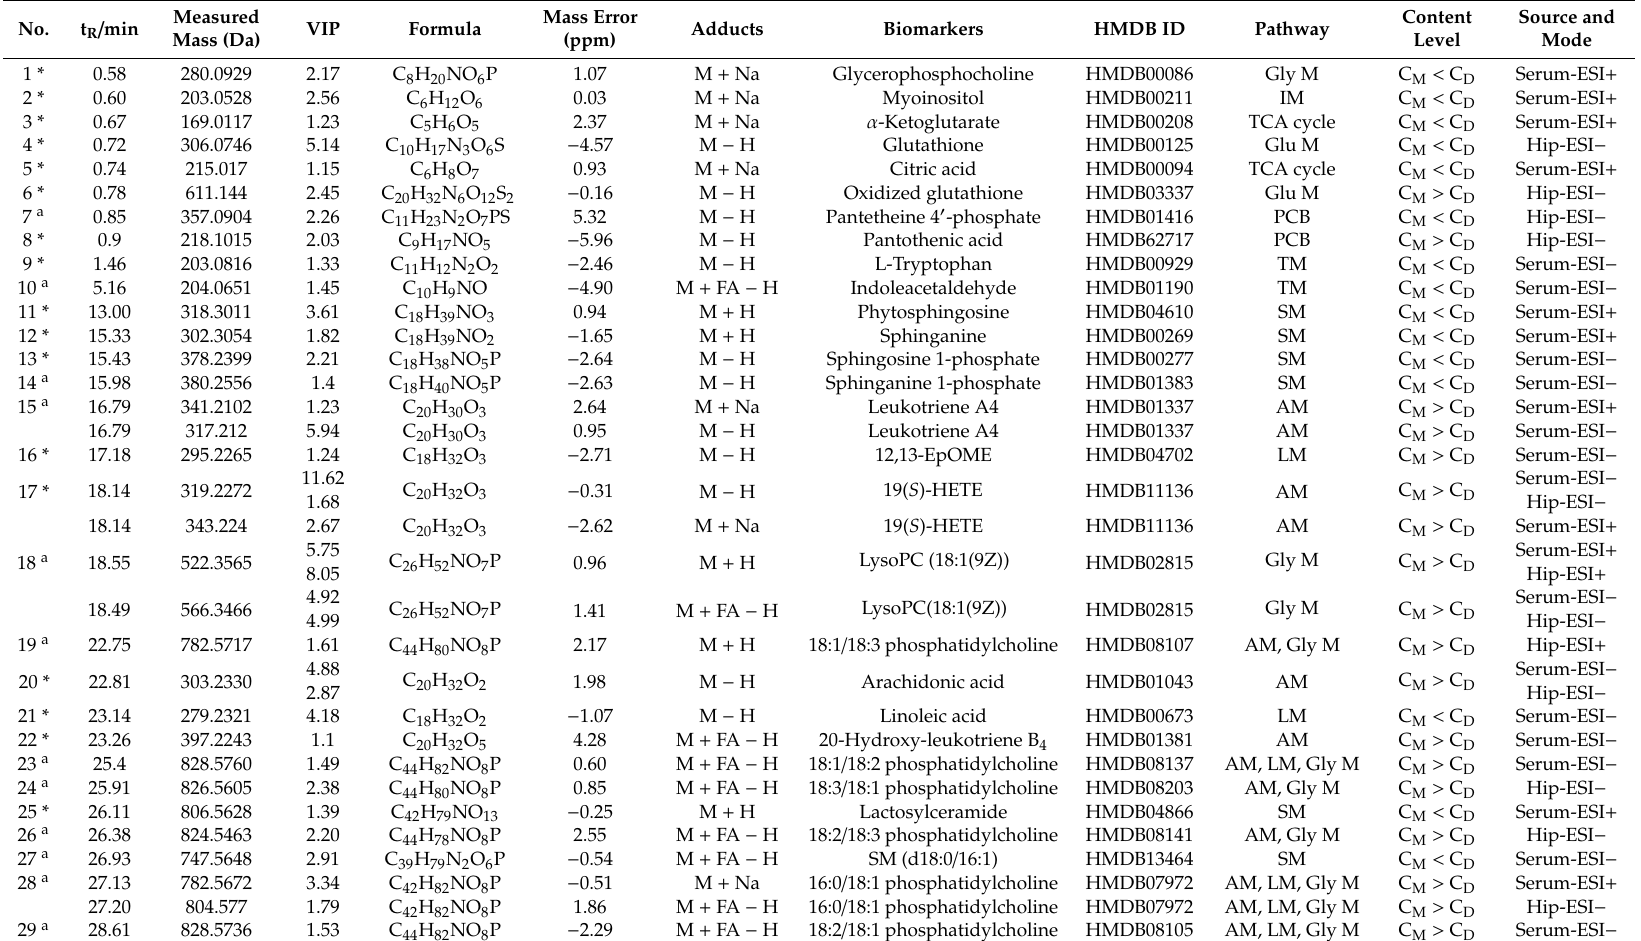
Table 1. Identification results of potential biomarkers in serum and the